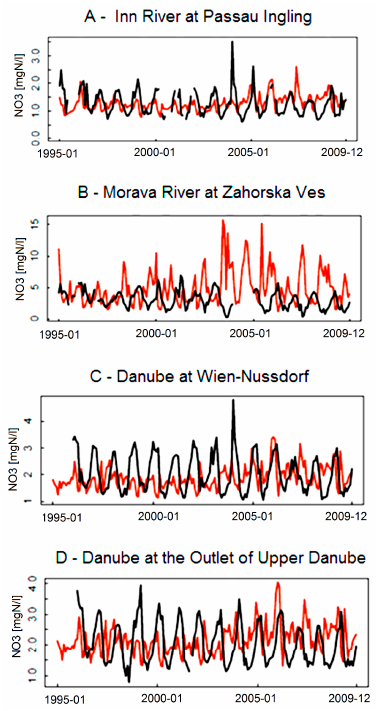
Figure 3. Visual appraisal of N ‐ NO 3 (mg/L) as observed (black line) and as simulated by SWAT model (red line) for the period 1995–2009 at the Inn River ( A ); Morava ( B ); Danube at Wien Nussdorf ( C ) and at the Outlet of Upper Danube ( D ). The location of these stations are reported in Figure 1.